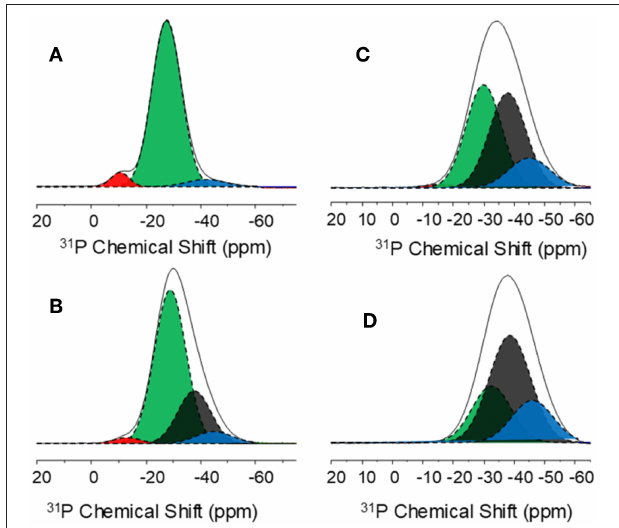
FIGURE 2 | Deconvolution of 31 P MAS NMR spectra for (A) P50, (B) Al5, (C) Al10, and (D) Al15 glasses. Q 1 , Q 2 and Q 3 peaks are indicated by red, green, and blue curves. The black Gaussian peak represents the Q 2,1 peak formed in Al-containing glasses.